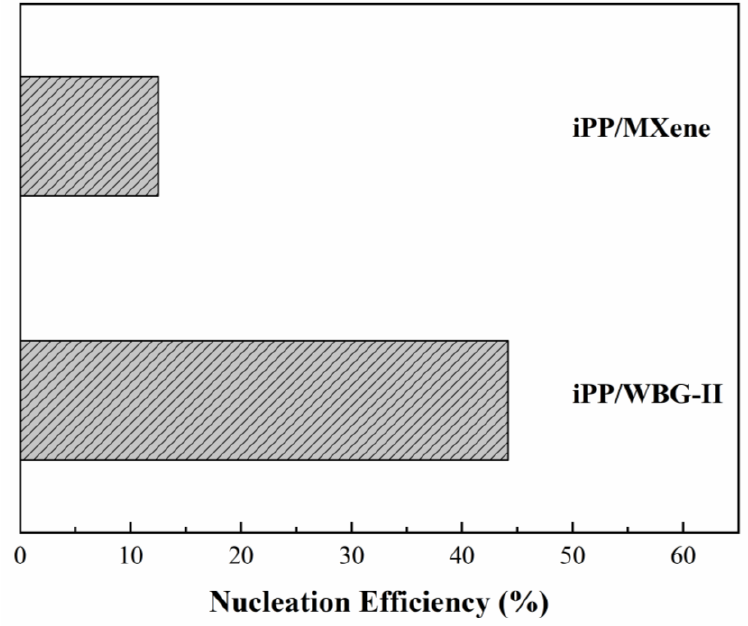
Figure 6. The plot of nucleation efficiencies (NEs) of iPP/WBG-II and iPP/MXene.